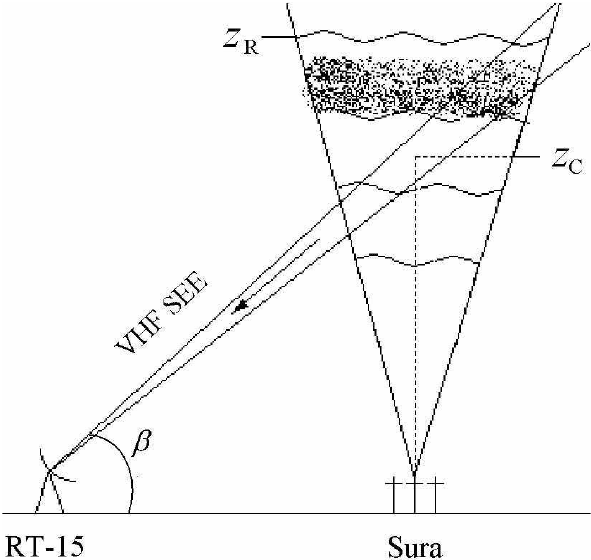
Fig. 1. Schematic plot of the experiment.